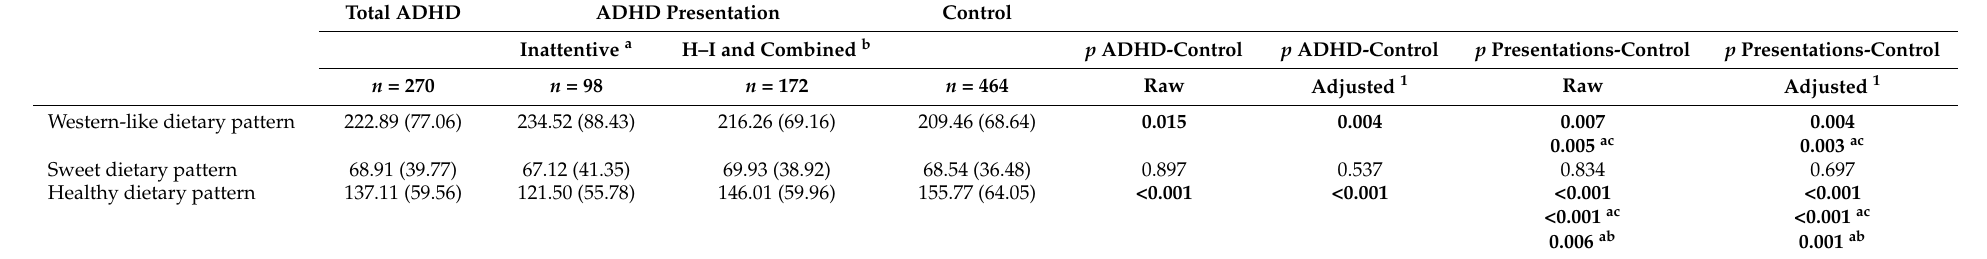
Table 3. Dietary pattern by diagnosis and ADHD presentation.